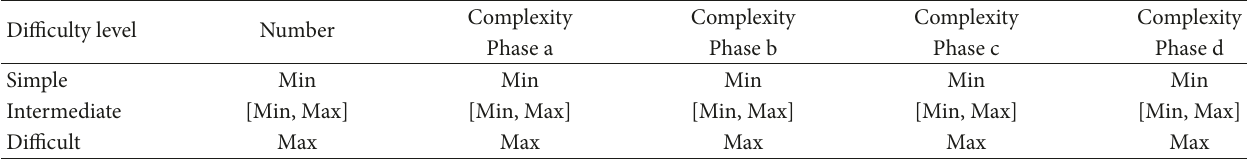
Table 5: Example of problems/obstacles